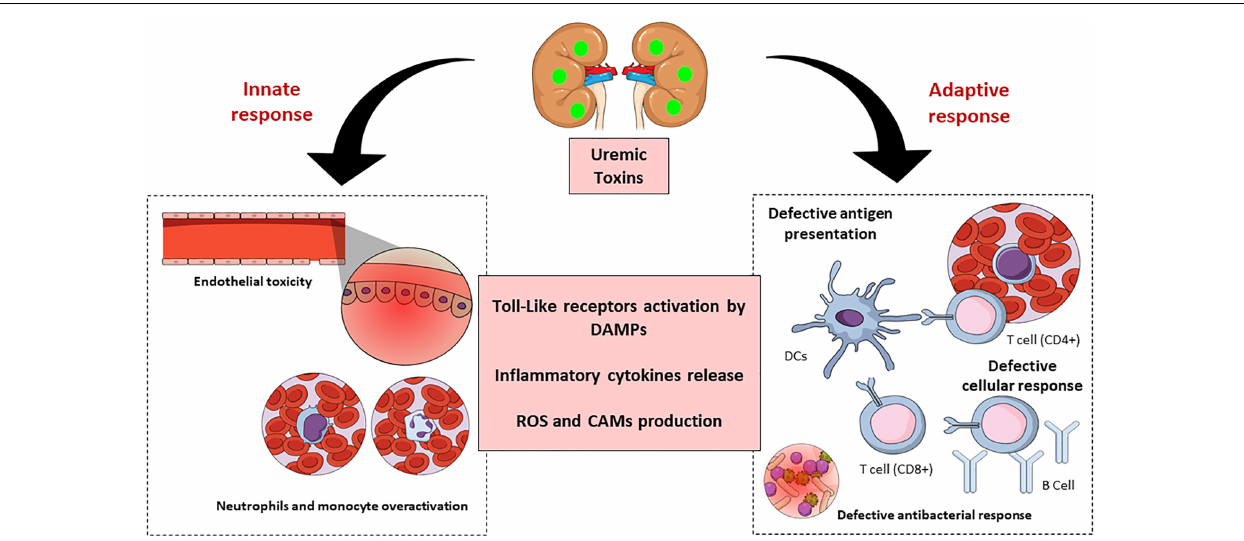
FIGURE 4 | Schematic representation of chronic kidney disease (CKD)-associated immune dysfunctions. Chronic kidney disease leads to the accumulation of uremic toxins, which have an impact on innate and adaptive immune systems. The uremic toxins impair endothelial cells function and induce chronic low-grade activation of innate immune effectors (monocytes and neutrophils) through the participation of TLRs and inflammatory cytokines. These substances also affect the adaptive immune system causing a defective antigen presentation which brings with it a defective cellular and humoral response. DAMPS, damage-associated molecular patterns; ROS, reactive oxygen species; CAM, cellular adhesion molecules; DC, dendritic